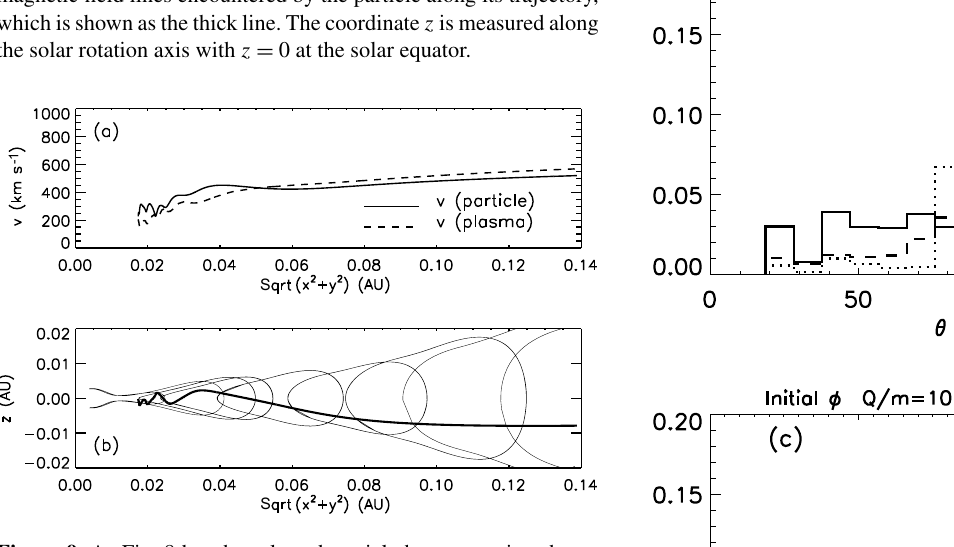
Figure 9. As Fig. 8 but the selected particle has a negative charge ( Q/m = − 10 − 5 e/m p ) and is released closer to the Sun. = | v − V | is the perpendicular speed of invariant, and v (cid:48) T T T the particle in the plasma frame. In Eq. (12) the non-leading Q/m -dependent drift terms are omitted. With this additional approximation, the particle (the guiding center) slides along the magnetic field line convected with the plasma flow. Figure 10. Distributions of (a) final velocity, (b) final colatitude, and (c) initial longitude for the time-extended case (CME followed by the time-stationary configuration) lasting ∼ 6 days. The distri- butions for non-escaping, rapidly escaping (escaping during the CME), and slowly escaping particles (escaping after the end of the CME) are shown. be written as C = B r r 2 , where B r is the radial component of B at the reference distance r = r